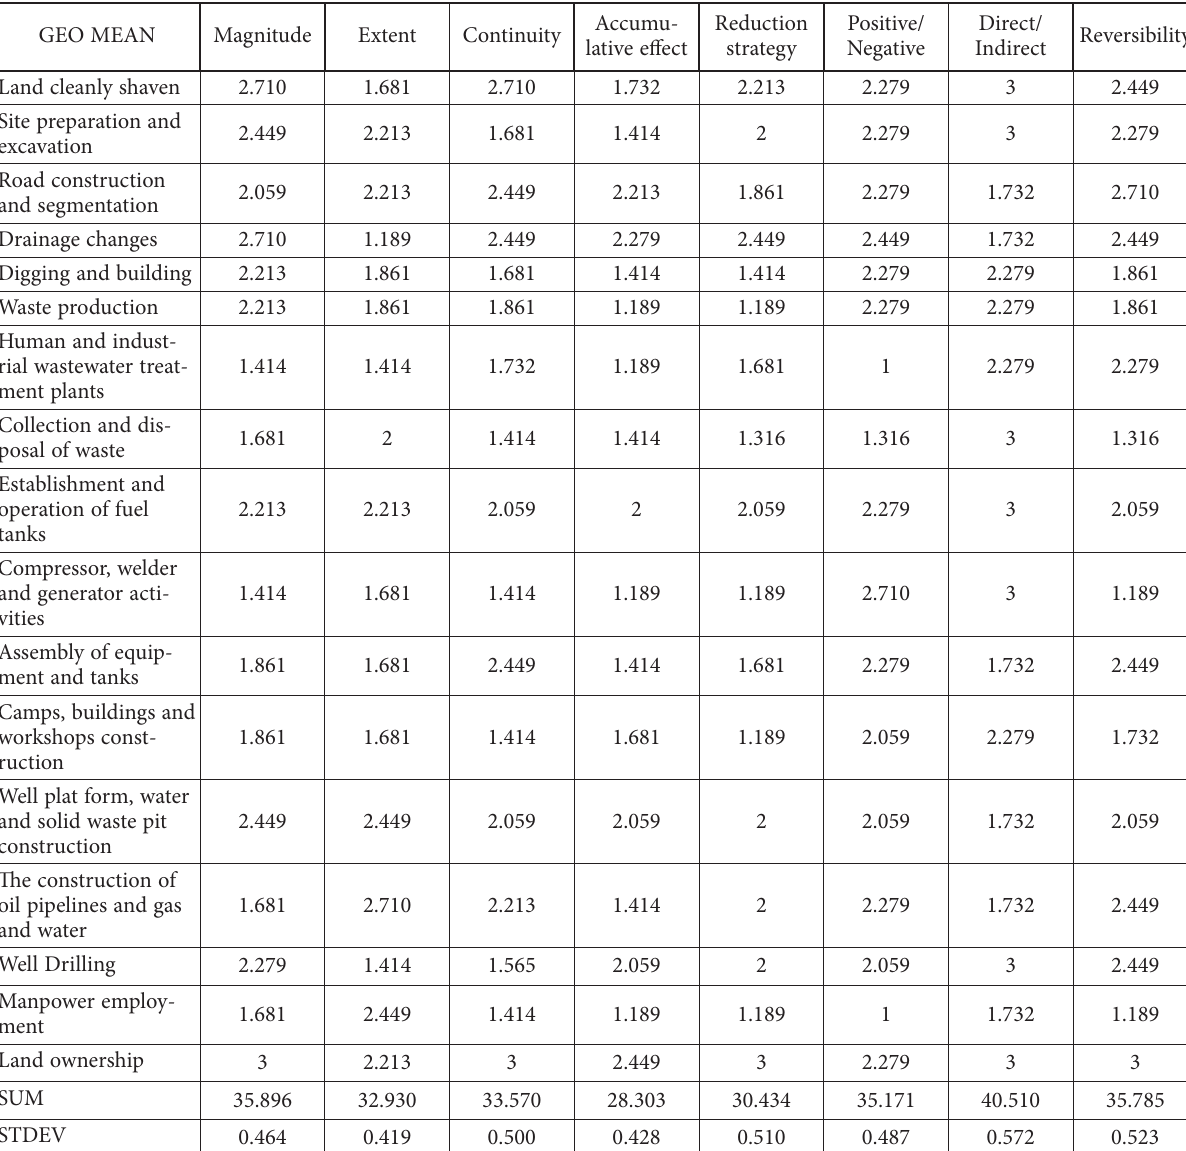
Table 2. Geo mean matrix of constructional phase